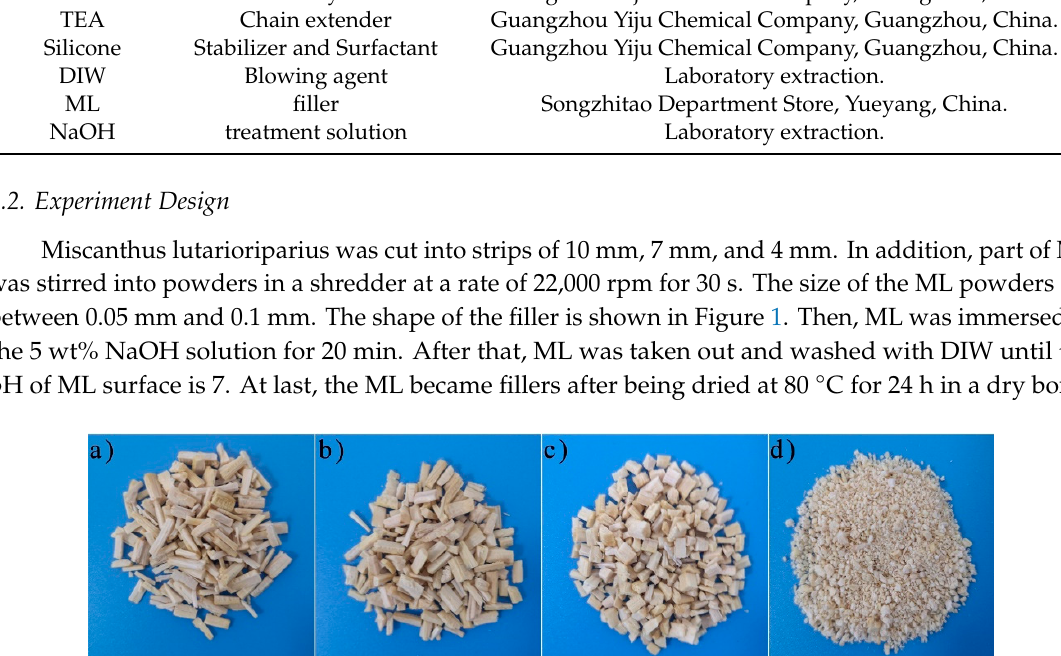
Table 1. Major information of the material.